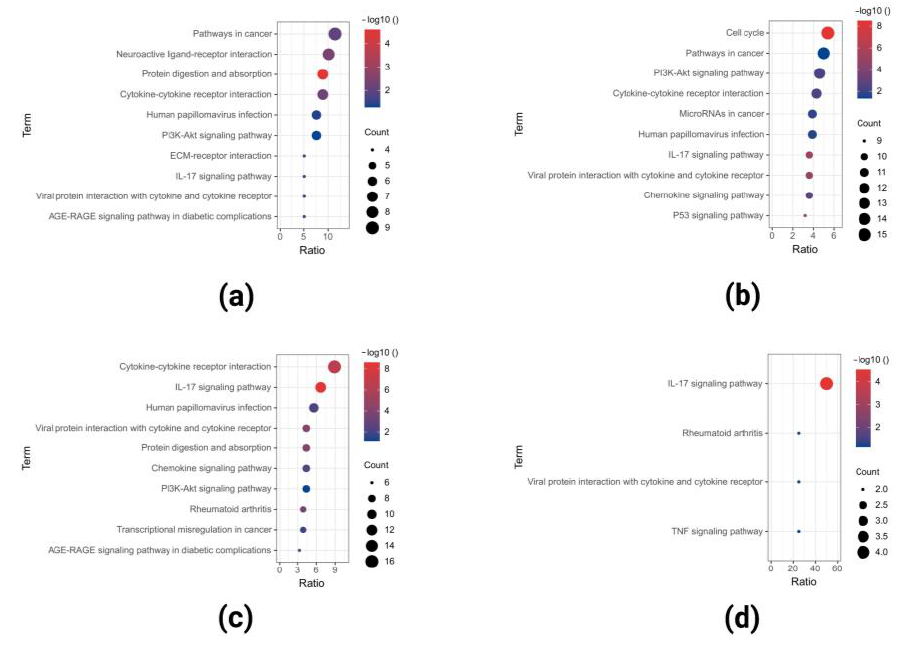
Figure 5. KEGG analyses of the upregulated DEGs in GSE40290 ( a ), GSE61218 ( b ), GSE53819 ( c ), and co-upregulated DEGs ( d ) in the three